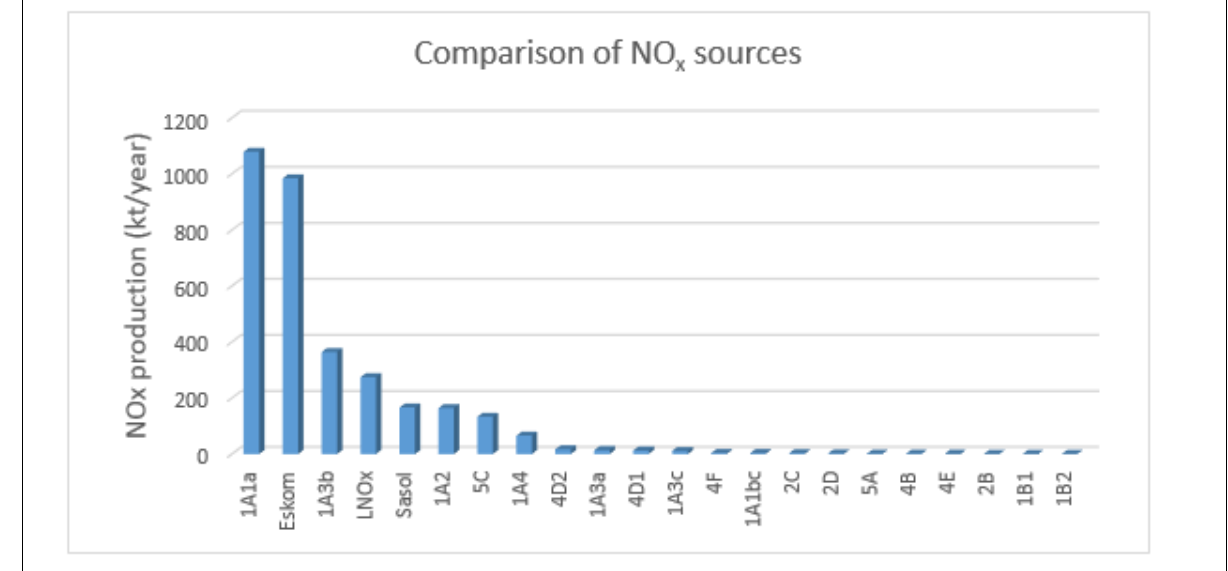
emission from EDGAR v4.2 and lightning for the year 2008 over South Africa, in kt NO Figure 9: NO 2